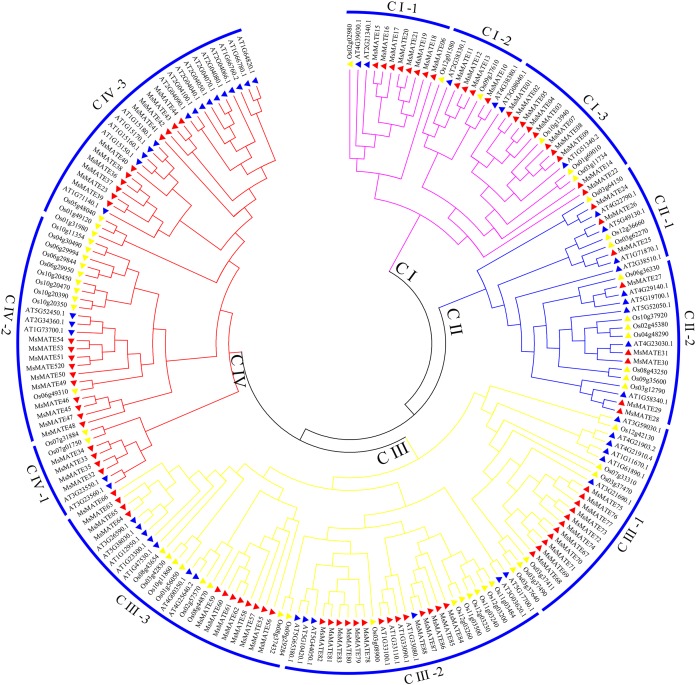
Phylogenetic tree of MATE proteins from Arabidopsis, rice, and alfalfa.The phylogenetic tree was constructed using MEGA7.0 and the neighbour-joining method with 1,000 bootstrap replicates. The tree was divided into four subfamilies comprising 11 smaller subgroups. Members of Arabidopsis, alfalfa, and rice are denoted by red, blue, and yellow triangles, respectively.